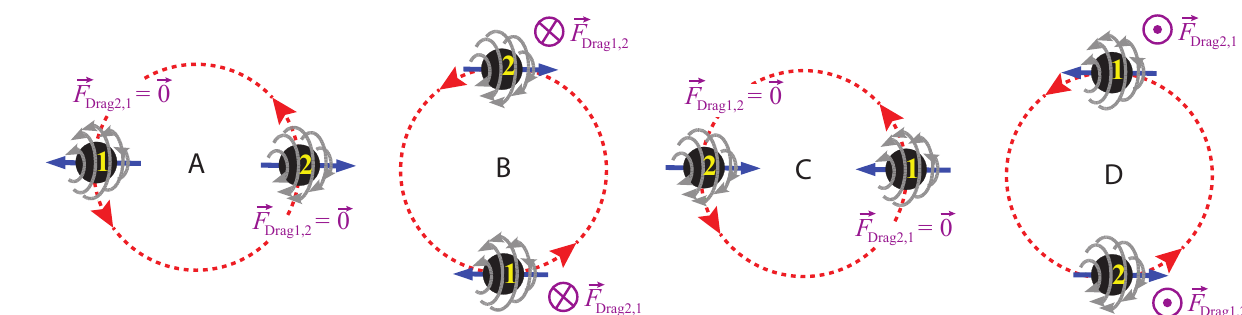
Figure 3. Incorrect prediction of the bobbing motions of “extreme kick” spinning black hole binaries, as would follow from the body-dragging misconception (illustration based on Figure 5 of [82]). Each black hole would be acted by a viscous-type dragging force ( (cid:126) F Drag ) originated by the spin of the other black hole; such forces would vanish when the black holes’ spins lie along the axis connecting them (phases A and C), and be maximum when the spins are orthogonal to such an axis (phases B and D), each black hole dragging the other inwards of the plane of the illustration in phase B, and outwards in phase D. None of these forces exist, however.